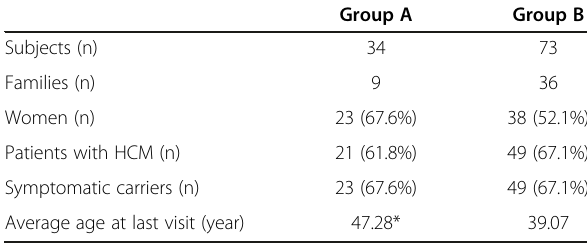
Table 2 Demographic data on the groups A (MYBPC3